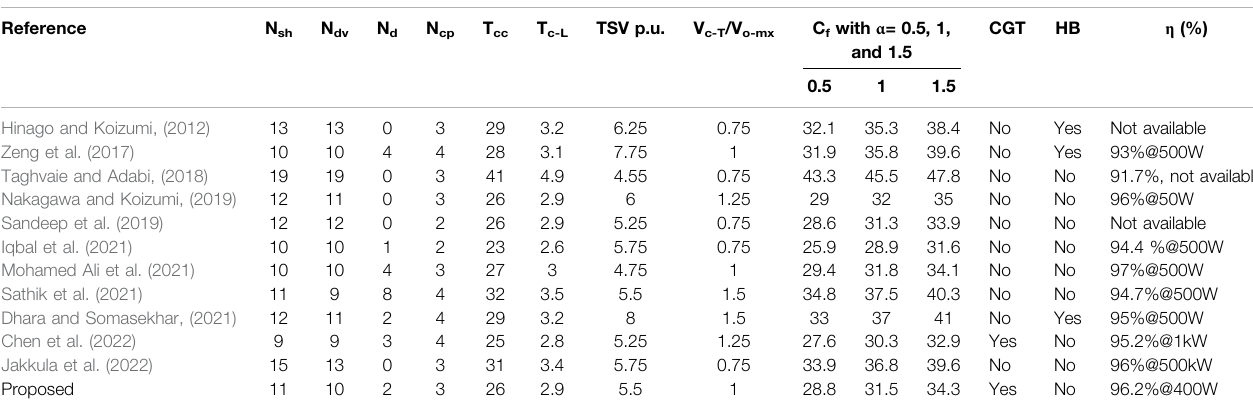
TABLE 2 | Comparison with other recent 9L topologies.